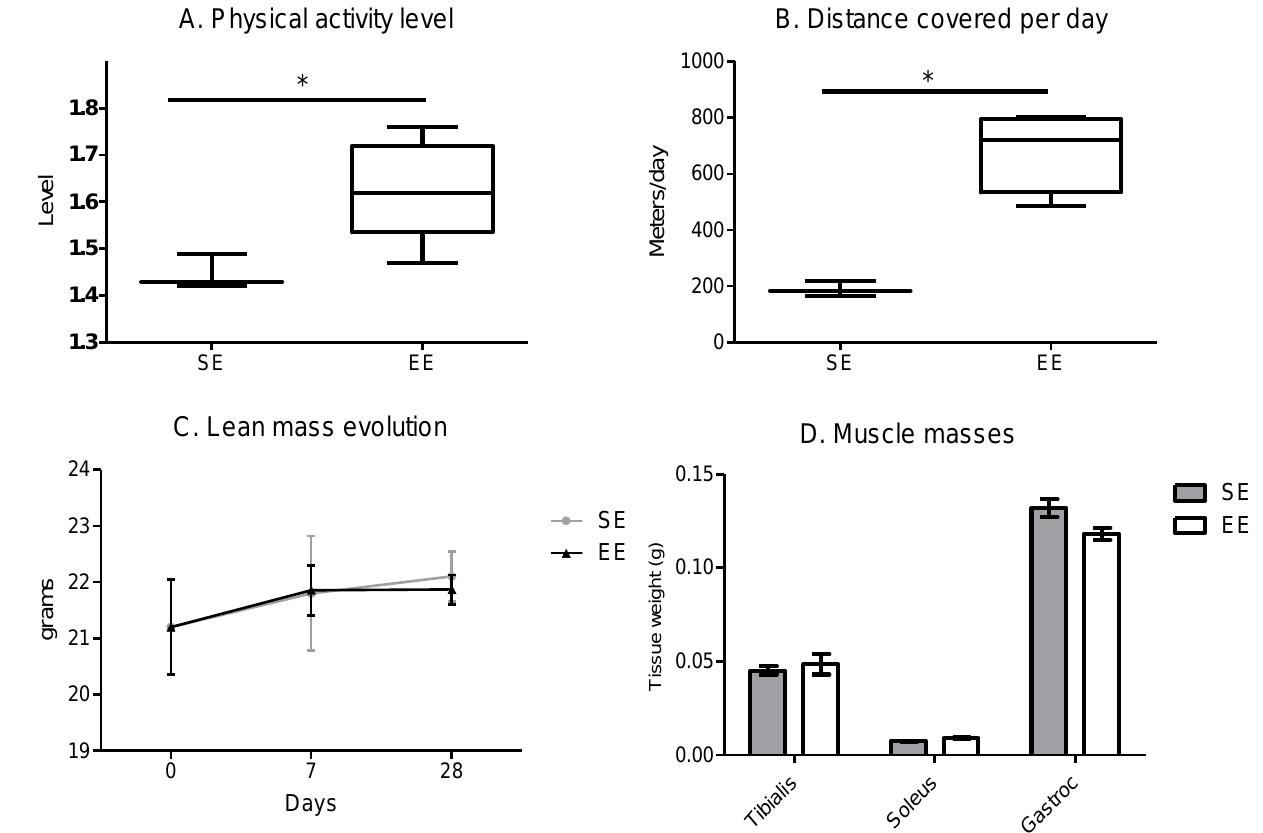
Figure 1. Enriched environment increases spontaneous physical activity with no change in lean mass. ( A ) level of physical activity per day per mouse, analysed by TSE system, correspond to total energy expenditure divided by the minimum energy expenditure expressed for a mouse. (means of 5 days follow-up at week 4) ( B ) distance covered per day per mouse, analysed by TSE system, results are in meters. (means of 5 days follow-up at week 4) ( C ) time course of lean mass per mouse analysed by EchoMRI. (means of 10 mice/group/days) ( D ) muscle masses of the posterior legs at sacrifice in grams (means of the two legs per 10 mice/group). Results are mean ± SEM. Data were analysed by Mann – Whitney t -test. Representative data are shown: * p < 0.05, SE vs. EE.